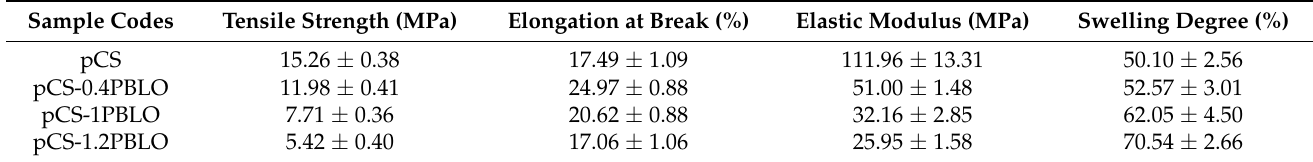
Table 2. The swelling degree and mechanical properties of pCS, pCS-0.4PBLO, pCS-1PBLO, and pCS-1.2PBLO. Sample